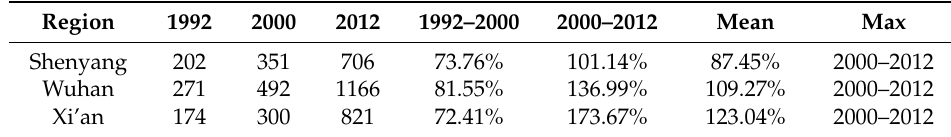
Figure 8. Extraction results for the built-up areas. Table 4. Statistics of the built-up areas (km 2 ).